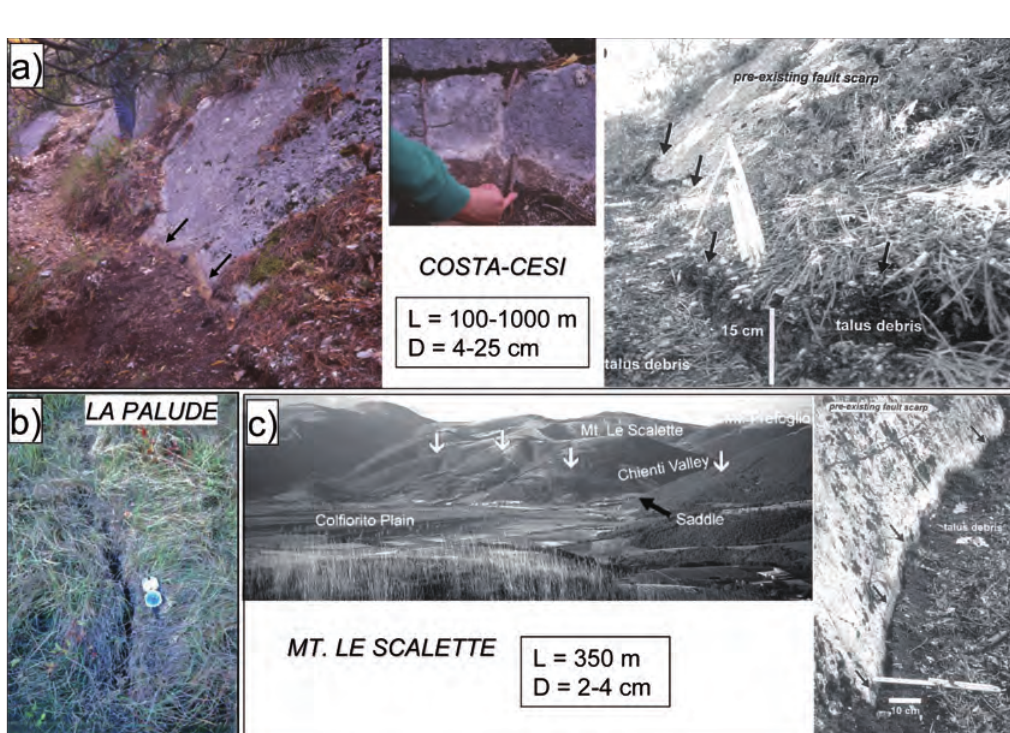
Fig. 5a,b,c. a) Left: Fresh exposure of the Costa bedrock fault scarp marked by a dark brown strip of soil, which is indicated by black arrows (photos courtesy of E. Tondi). This feature is interpreted by Cello et al. (1998) as reactivation of the fault plane. Middle: Detail of the exposure at the Costa site. The strip height and also offset roots were used as slip indicators on the fault plane. Right: Detail of a feature near the village of Costa interpret- ed by Basili et al. (1998) as a gravitational structure affecting debris slope (arrows point to the scree band; pho- to from Basili et al. , 1998). The white bar indicates the height of the exposure; b) A ~500 m-long set of open fractures (N145 average trend, O max = 5 cm) in a ploughed field by the flat area of La Palude (photo by F.R. Cin- ti); c) Panoramic view of the Colfiorito basin from south-east looking north. White arrows indicate the bedrock fault scarp (photo from Messina et al. , 2002). To the right: the arrows point to the scree band observed along the Mt. Le Scalette fault plane (photo from Basili et al. , 1998), where the hanging-wall debris cover detached from the smooth fault plane. Symbols: L = Length, D =